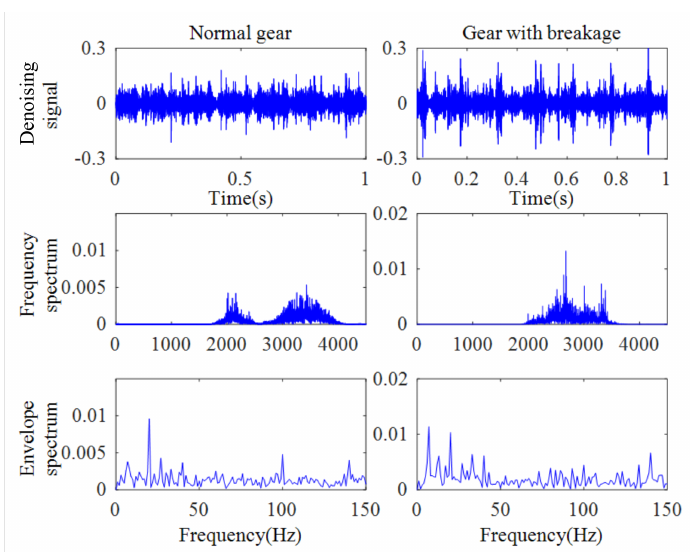
Figure 14. Denoising results based on traditional SVD.